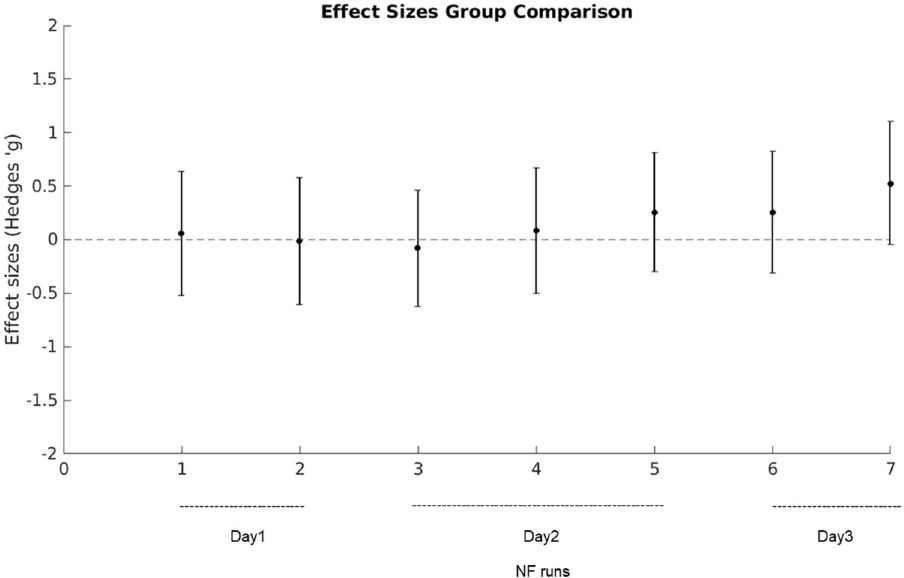
Figure 3. Effect sizes of the group comparison. Effect sizes (Hedges’ g with 90% confidence interval) of the group comparison testing for differences in DLPFC-striatum FC between the real feedback group and the yoke control group for each NF run. An effect of g = 0.5206 was found in NF run 7 at day